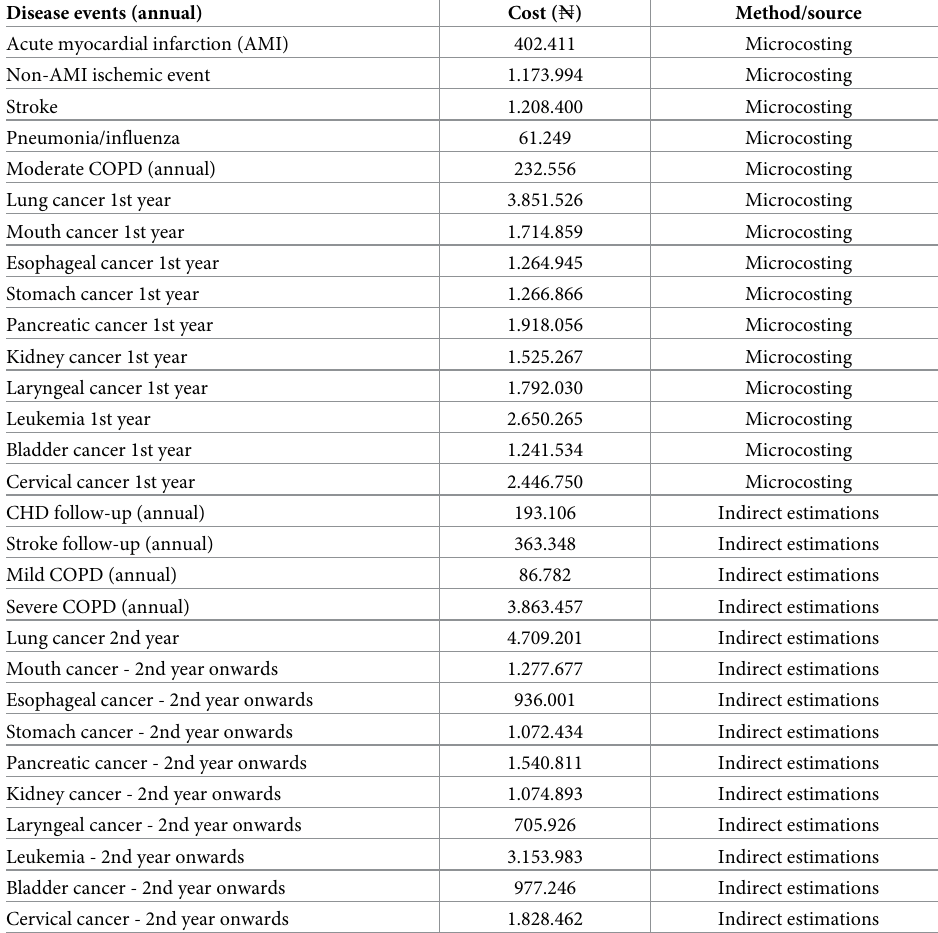
Table 2. Estimated direct medical costs (in ₦ as of March 2020).